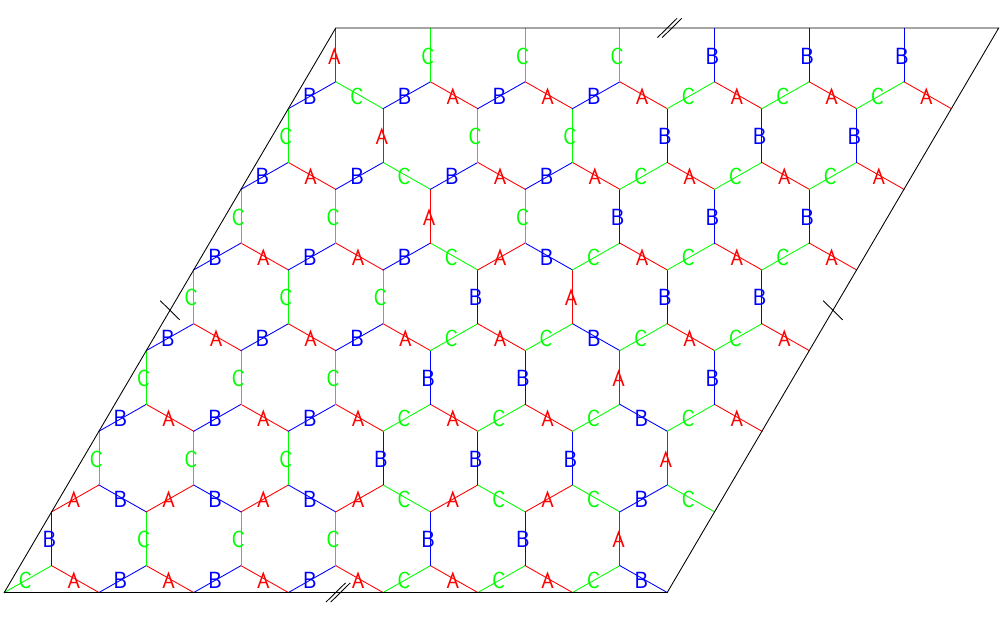
Figure 1: Example of a 3-coloring of the N = 3 L 2 edges of a hexagonal lattice of linear size L = 7. Periodic boundary conditions are used to form a torus and define homotopy classes.